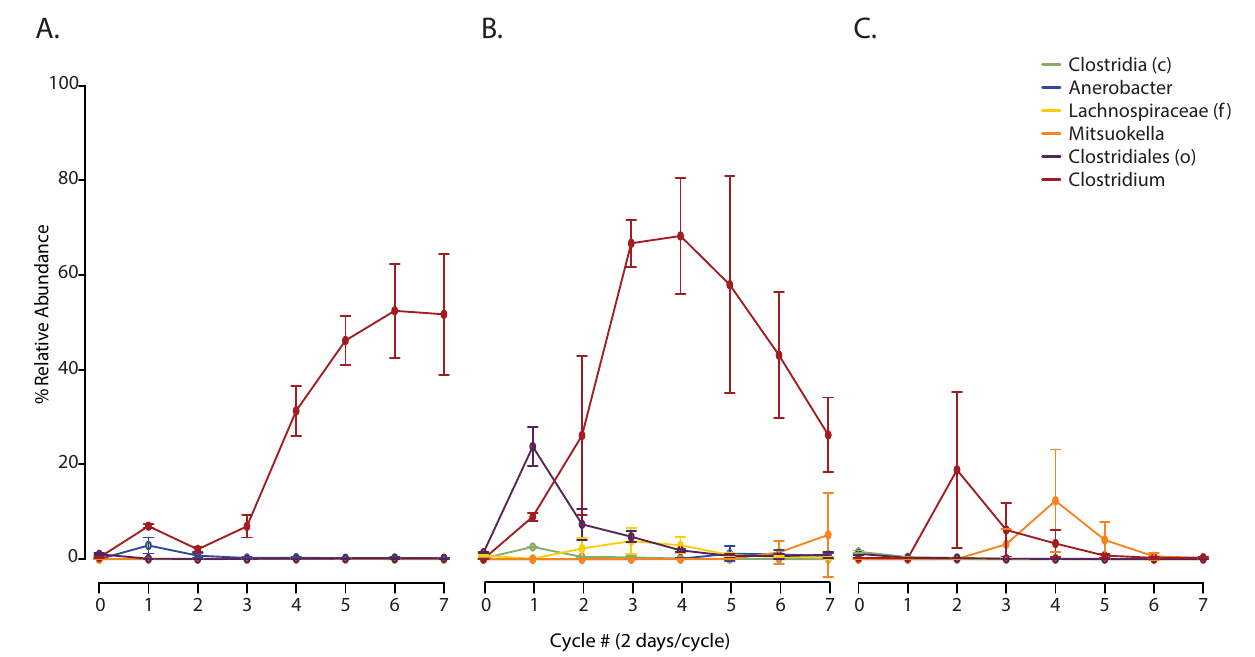
Fig 6. Dynamicsof abundant Clostridia species are distinct to starting inoculum. We illustrate changesin averagerelative abundances of ClostridiaOTUs over time in Camel (A) , Mangrove (B) , and Sludge (C) bioreactors.Abundanceis represented as average percent relative abundance. OTUs were filtered for equal or greater than 0.1% relative abundance across all time points, and are labeled with the lowest taxonomicclassificationidentified, genus level unless otherwisenoted (f, family; o, order; c, class).